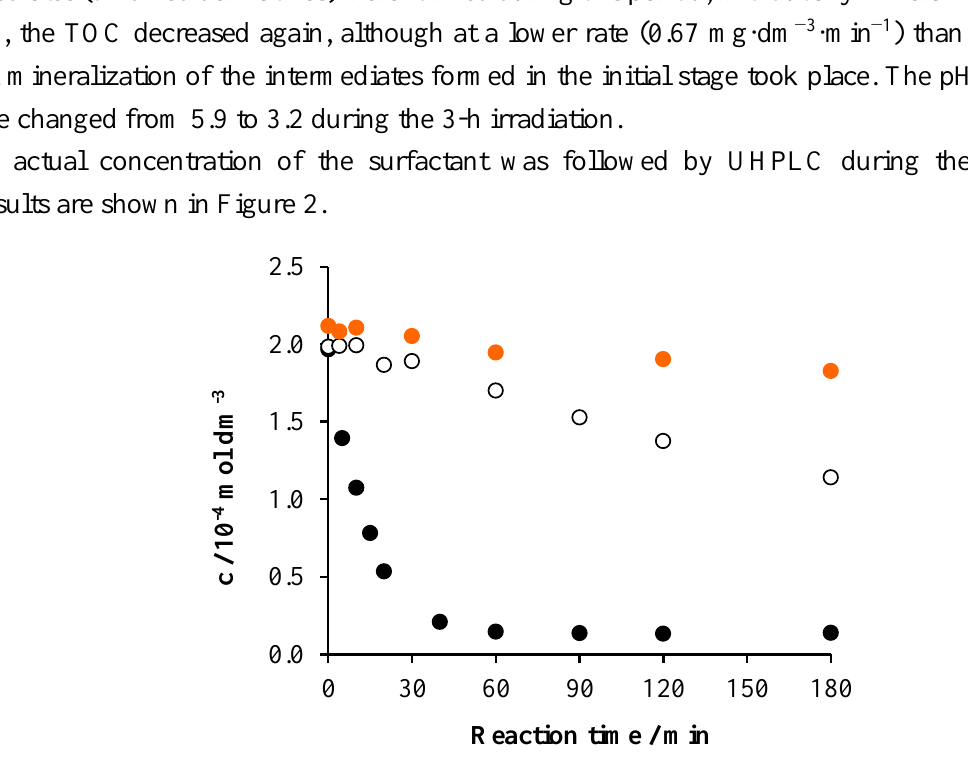
Figure 2. The change of the Triton X-100 concentration as a function of the reaction time under various conditions in the system containing 2 × 10 −4 mol·dm −3 Triton X-100 and 1 g·dm −3 TiO 2 : air (•), air/UV (○) and air/UV/TiO 2